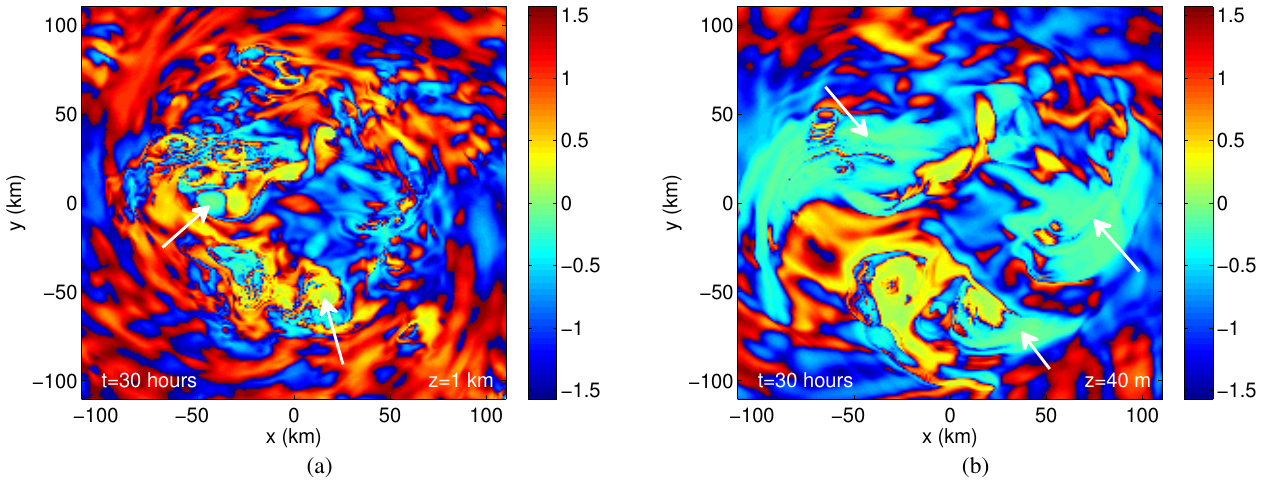
Fig. 9. ϕ is shown for a 1 hour integration time at t = 30 hours at z = 1 km (a) and z = 40 m (b). Arrows indicate regions of Lagrangian neutral stability.